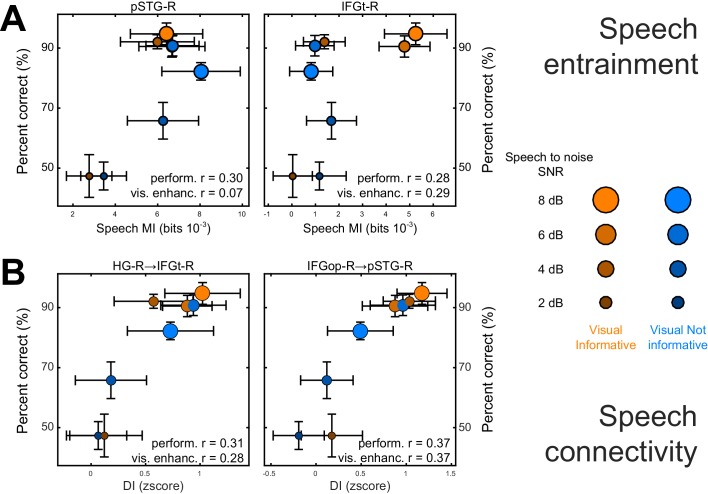
Neuro-behavioral correlations.(A) Correlations between behavioral performance and condition-specific speech MI (perform. (r), and correlations between the visual enhancement of performance and the visual enhancement in MI (vis. enhanc. (r). (B) Same for DI. Only those ROIs or connections exhibiting significant correlations are shown. error-bars = ± SEM. See also Tables 2–3. Deposited data: BEHAV_perf; SE_meg; DI_meg; SE_miS; DI_di; NBC_miS; NBC_di.